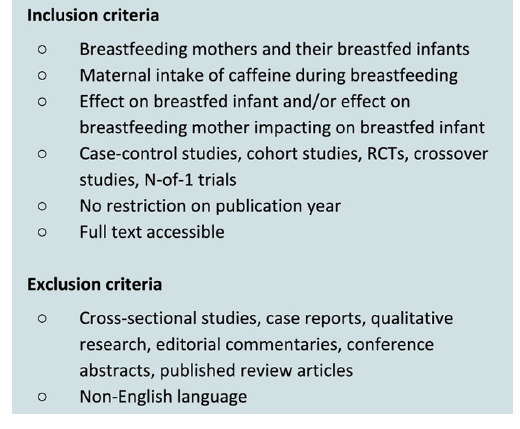
Figure 1: Inclusion and exclusion criteria.RCT = randomised con- trolled